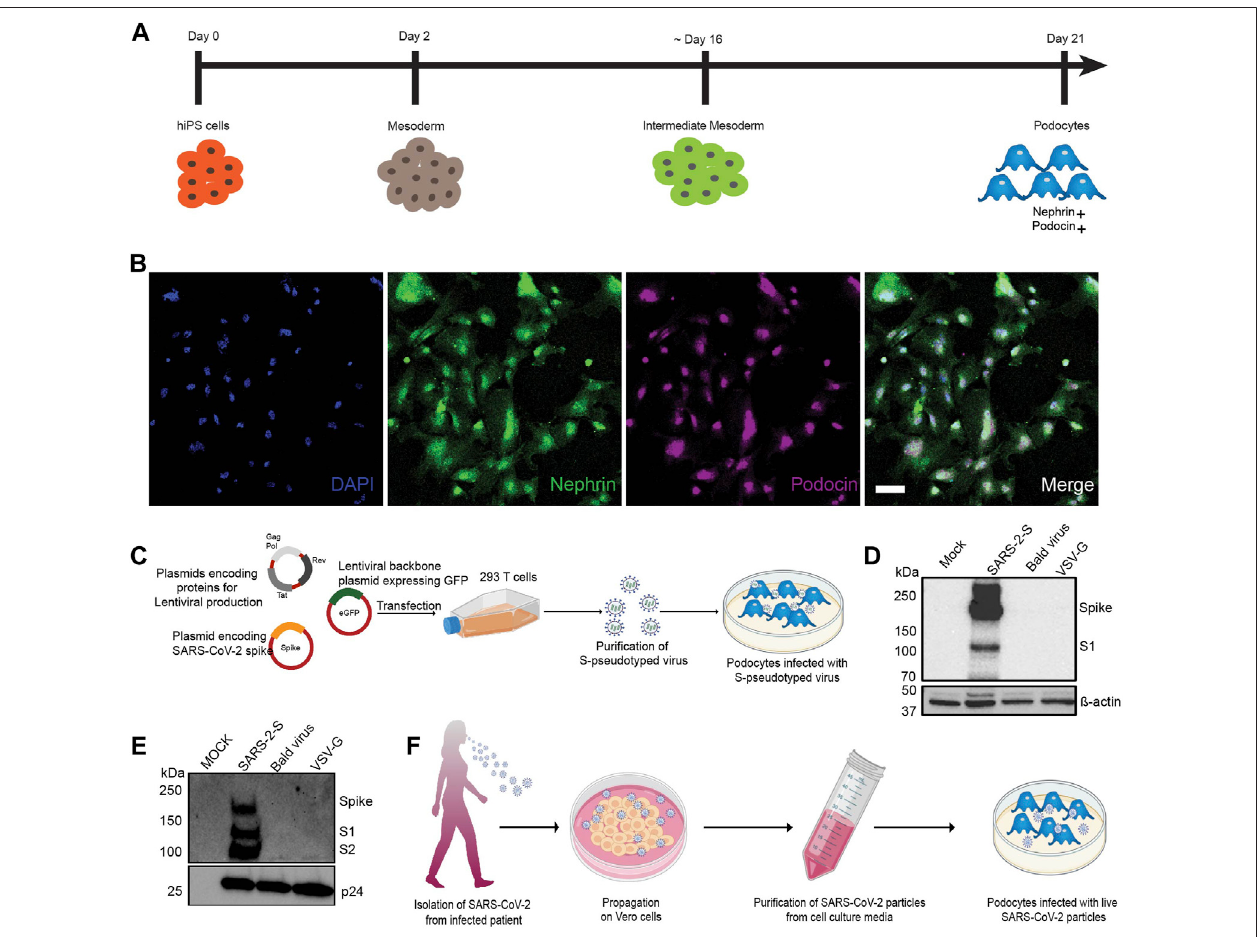
FIGURE 1 | Establishment of a method to examine susceptibility of human iPS cell-derived podocytes to SARS-CoV-2 infection. (A) Schematic overview of the protocol for the differentiation of mature podocytes from human iPS cells; adapted from (Musah et al., 2017). (B) Human iPS cell-derived podocytes express the lineage speci fi c markers nephrin (green) and podocin (magenta). Cells were counterstained with DAPI (blue) nuclear marker. Scale bar, 100 μ m. (C) Schematic depicting the lentiviralvectorsusedtoproduceS-pseudotypedvirusfrom293TcellsandinfectionofhumaniPScell-derivedpodocytes invitro . (D,E) Westernblotcon fi rmingthe successful transfection of 293T cells and production of S-pseudotyped virus indicated by the presence of Spike protein (190kDa) and its cleavage products S1 (~110 kDa)inboth (D) thecelllysates( β -actinusedasloadingcontrol)and (E) puri fi edviralparticle(normalizedtoHIVviralproteinp24)withextrabandforS2(~100 kDa). Mock for fi gure D represents lysate from untransfected cells while in E, mock represents pseudoviral particle dissolving media (TBS); SARS-2-S represent lysate from cells transfected with spike expressing plasmid or S-pseudotyped particle; Bald virus represent lysate from cells transfected with no envelope plasmid or the resulting pseudovirus particle without viral envelope protein; VSV-G represent lysate from cells transfected with plasmid expressing VSV-G or pseudotyped particle with VSV-G envelope (F) Schematic showing propagation of patient-derived SARS-CoV-2 virus in Vero E6 cells followed by puri fi cation and infection of human iPS cell-derived podocytes in vitro